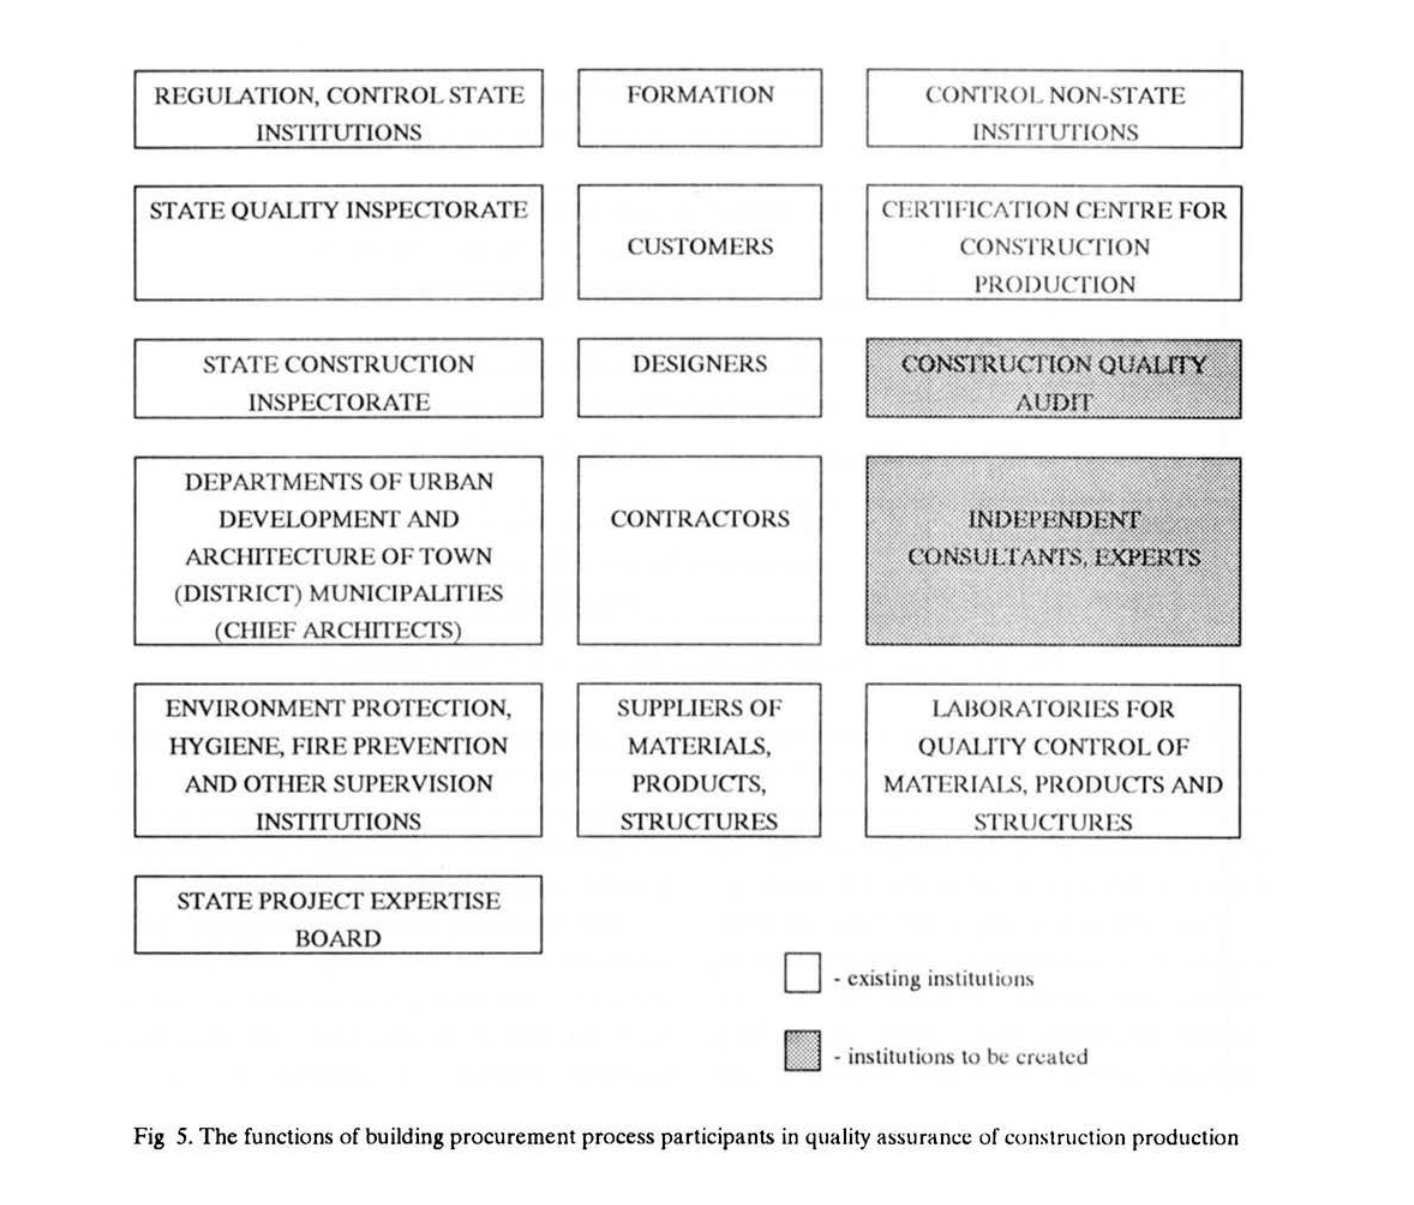
Fig 5. The functions of building procurement process participants in quality assurance of construction production